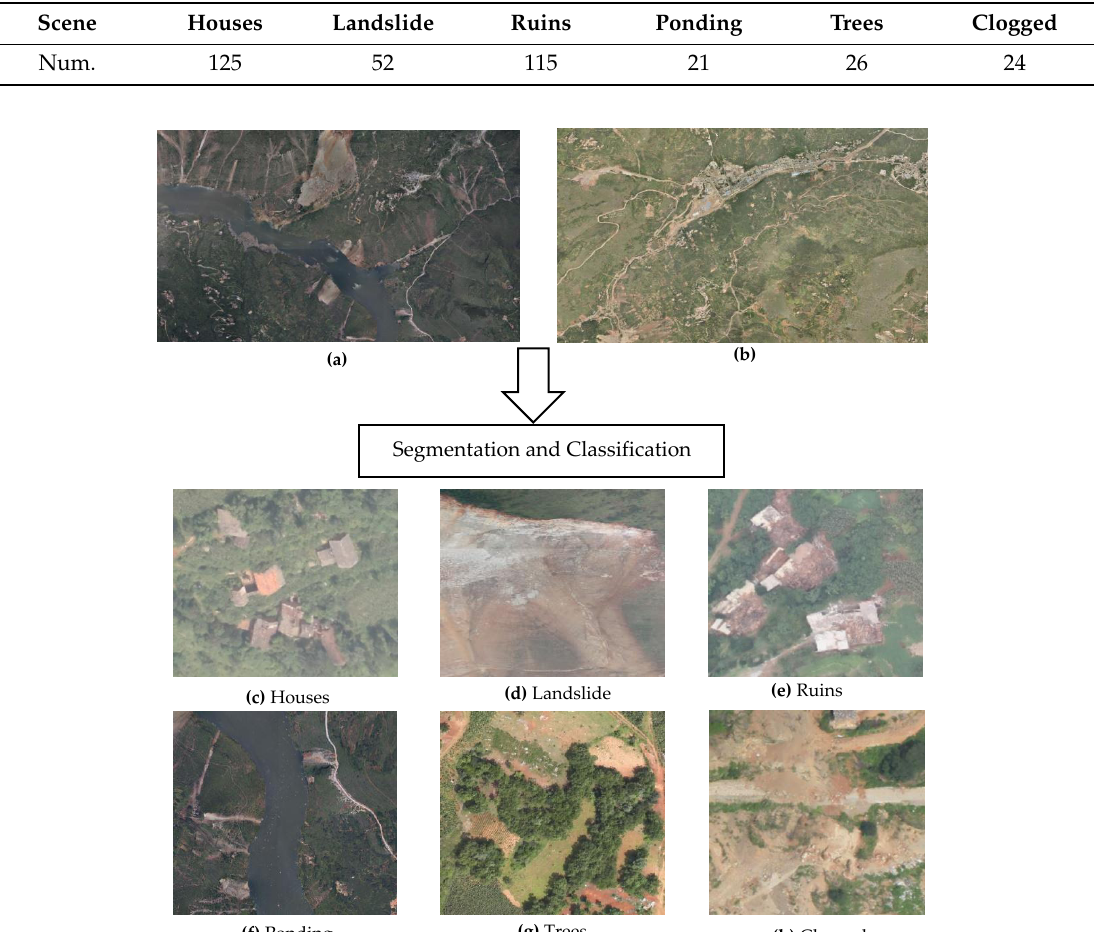
Table 2. Number of instances of each scene.